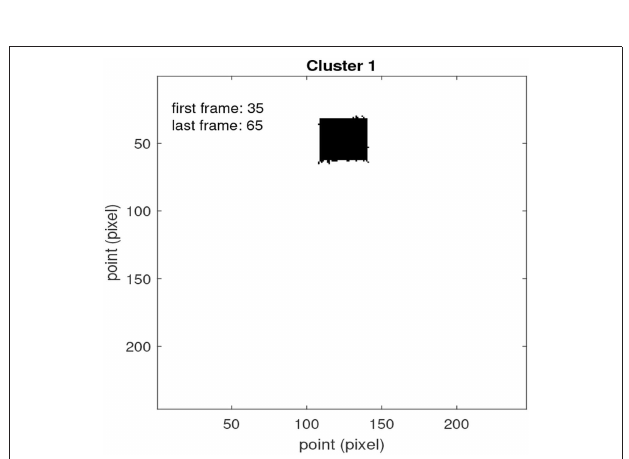
FIGURE 4 | (Left) locations of the most relevant points associated with the recurrent pattern in Figure 2 . (Right) region of recurrence identified after applying the geometric information to all relevant points identified, and a threshold on the minimum number of points a region of recurrence should contain (set to 100 points for this example).